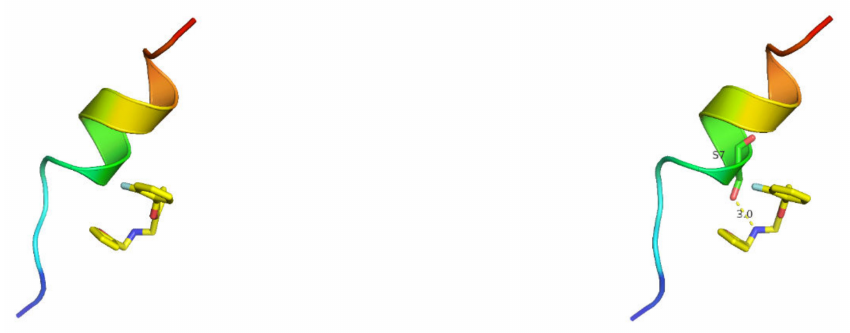
Figure 7. Docking results of plantaricin YKX with Al-2 of S. aureus . ( Left ): homology modeling results. ( Right ): docking